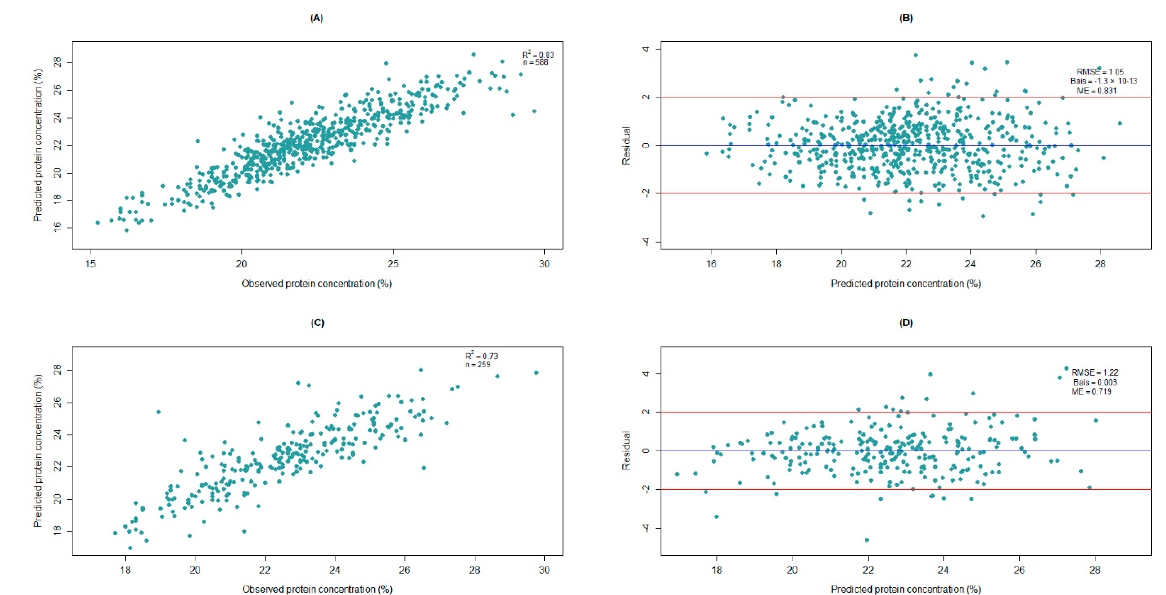
Figure 4. Different plots for partial least square regression (PLSR) using DA7250 spectral data: ( A ) scatter plot of predicted values against observed values for the calibration set, ( B ) plot of residual values against predicted values for the calibration set, ( C ) scatter plot of predicted values against observed values for the validation set, and ( D ) plot of residual values against predicted values for the validation set.